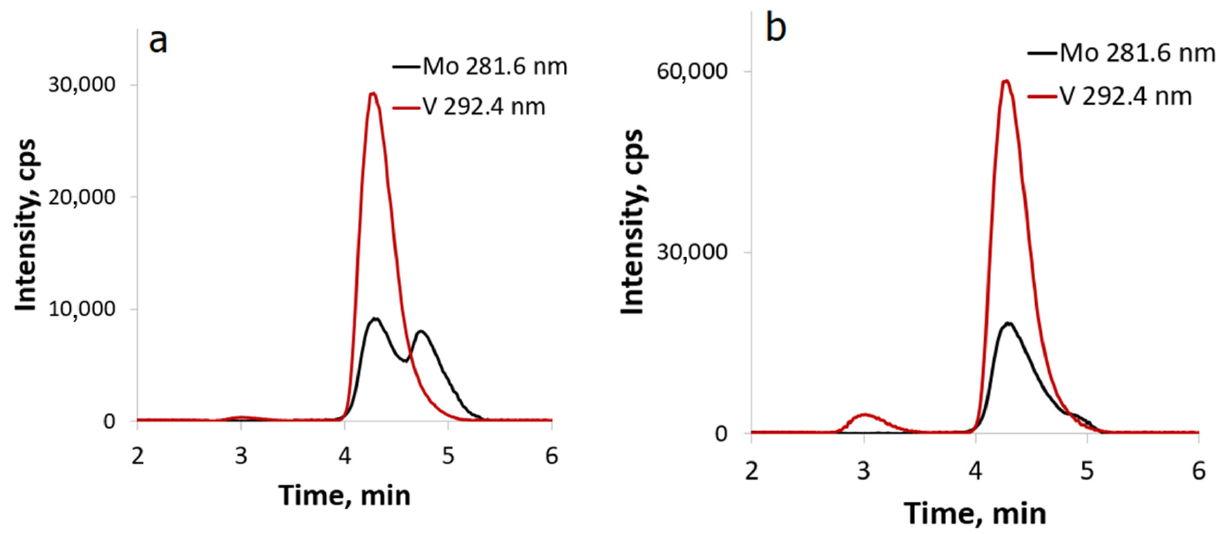
Figure 4. HPLC-ICP-AES chromatograms of the POM mixture at ( a ) the initial Mo/V ratio = 5/1 and ( b ) Mo/V ratio = 5/2.